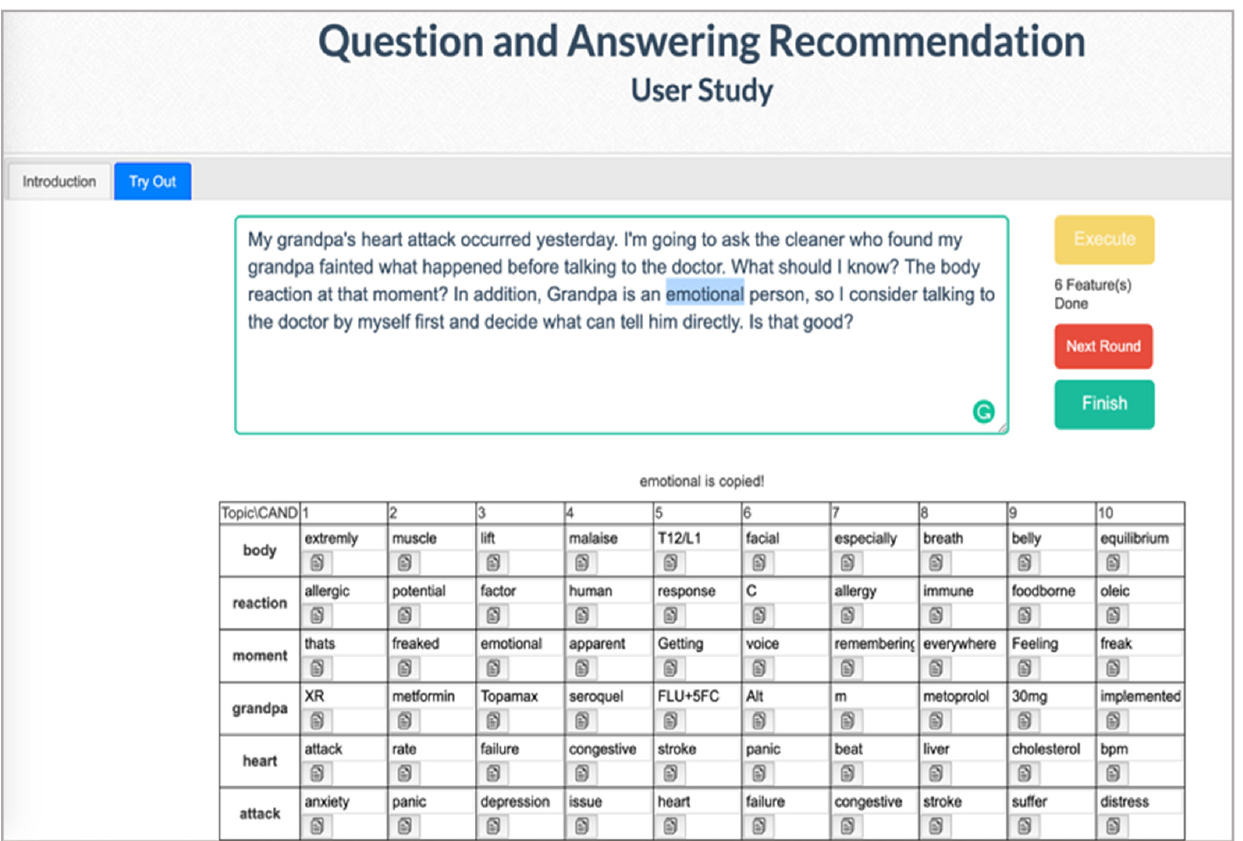
Figure 1. Interface of post RS.